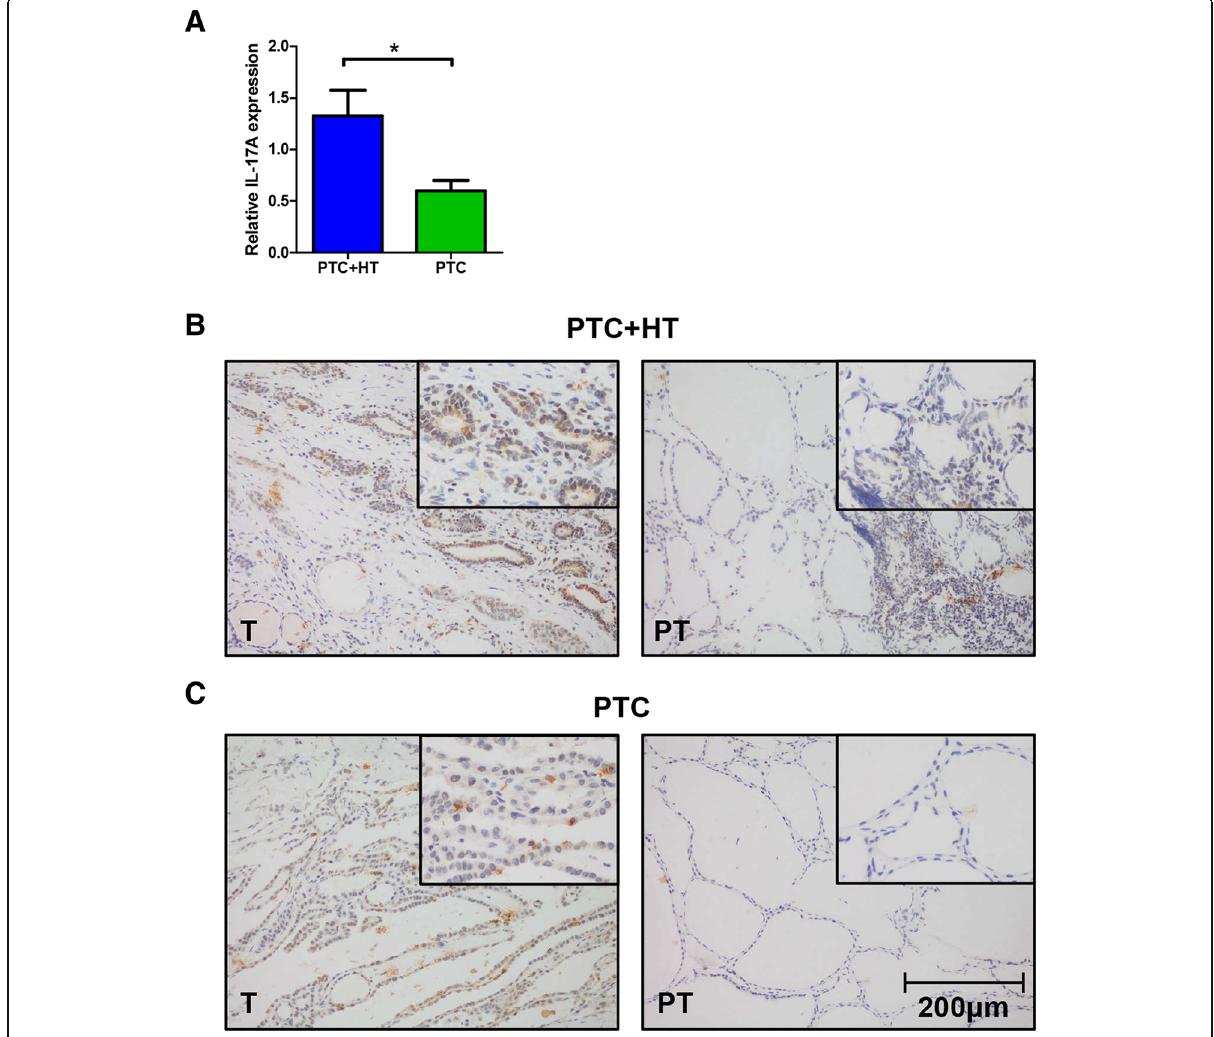
Fig. 1 Elevated IL-17A expression in PTC + HT. a , IL-17A expression in tumor tissues of PTC patients with or without HT measured by qPCR. ( * P < 0.05) b - c , representative pictures showing IHC staining of IL-17A in PTC + HT tumor and adjacent para-tumor tissue ( b ), PTC tumor and adjacent para-tumor tissue ( c ). (original magnification, 200×; the right upper quadrant,